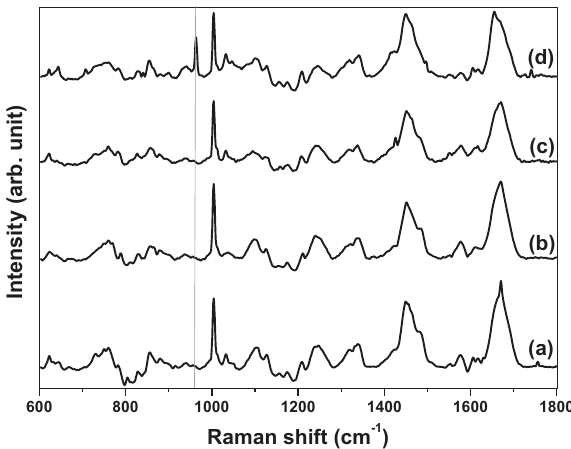
Fig. 4 Stack of averaged processed Confocal-Raman spectra ( n = 36) from the nuclei of three random single U-2 OS cells on quartz sub- strates. Cells derived from TI-HA-AD over 28 days in culture under standard conditions; a day 7, b day 14, c day 21, and d day 28. Grey solid line shows Raman peak at ~963 cm − 1 at day 28 (strong)